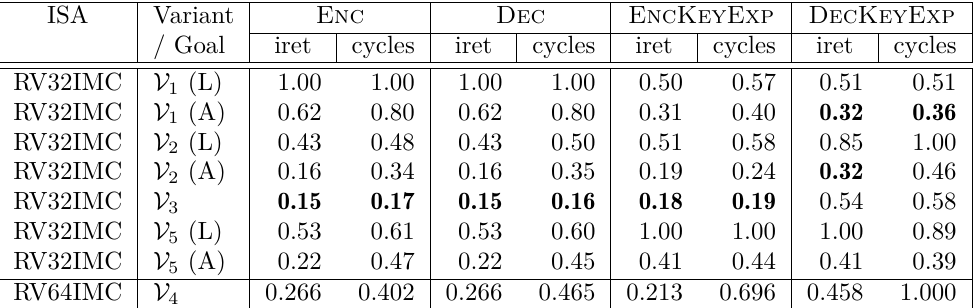
as used by GHASH . 2 128